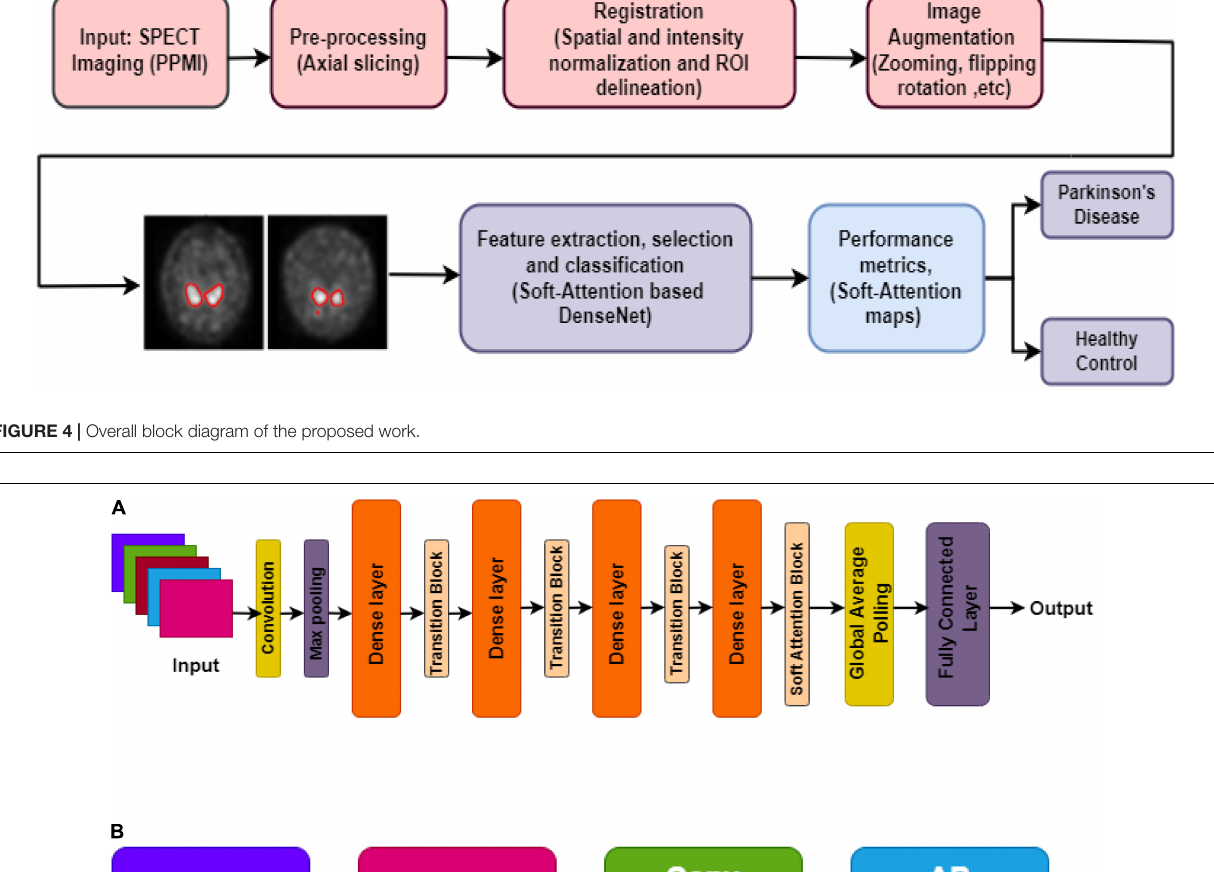
batch normalization, ReLU, and convolution or pooling. The resultant feature maps of each layer are provided as inputs to the succeeding connected layers after the non-linear